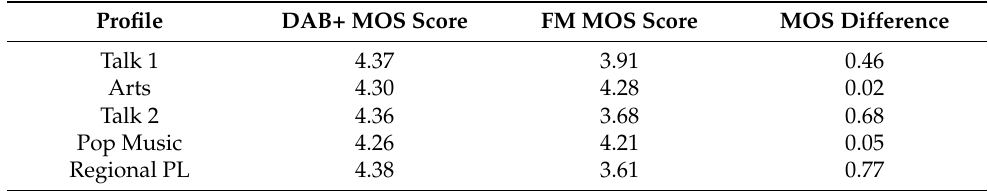
Table 7. Difference in subjective MOS judgements of simulcasted DAB+ and FM radio programs— evaluated multiplex ensemble configuration.